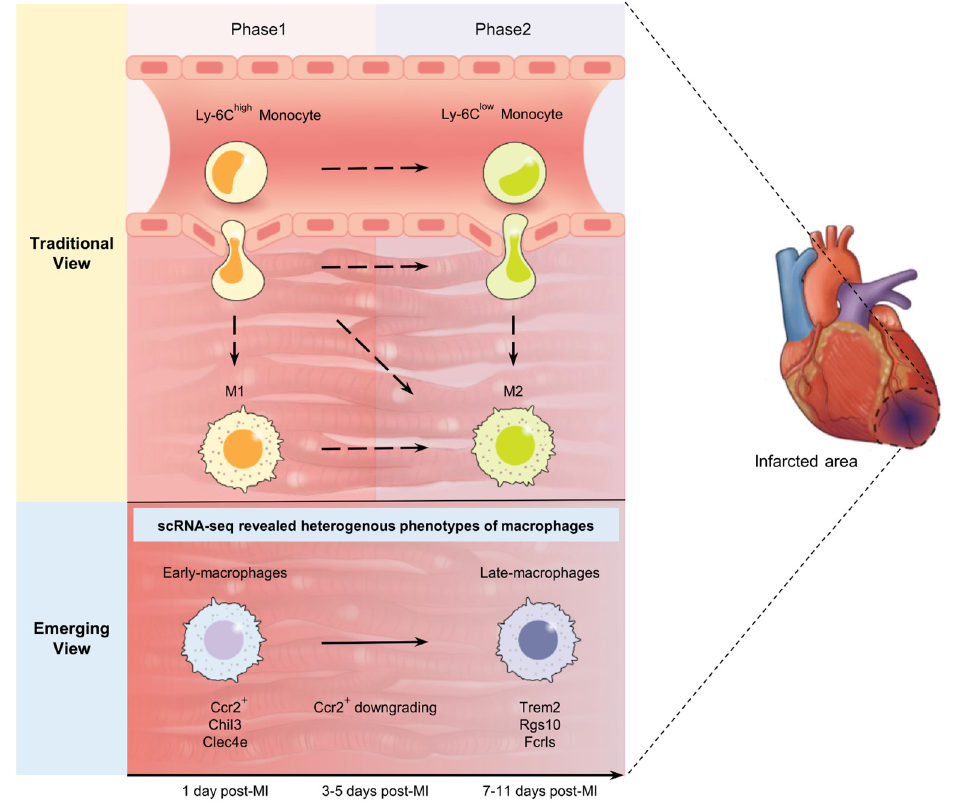
Figure 1. Traditional and emerging concepts of monocytes/macrophages in infarcted myocardium. The traditional concept defines the dichotomous classification of Ly-6C2 hi /Ly-6C2 low monocytes and M1/M2 macrophages by the temporal phase. Inflammatory Ly-6C2 hi monocyte-derived M1 macrophages reside in the earlier phase, while regenerative Ly-6C2 low monocytes and derived M2 macrophages reside in the later phase. An emerging concept discriminates the heterogeneous transcriptomic genotypes of monocytes and macrophages in infarcted myocardium. Macrophage subsets with a heterogeneous spectrum of gene expression suggest the differentiation or dynamic interchange of immune cells in the course of myocardial infarction.